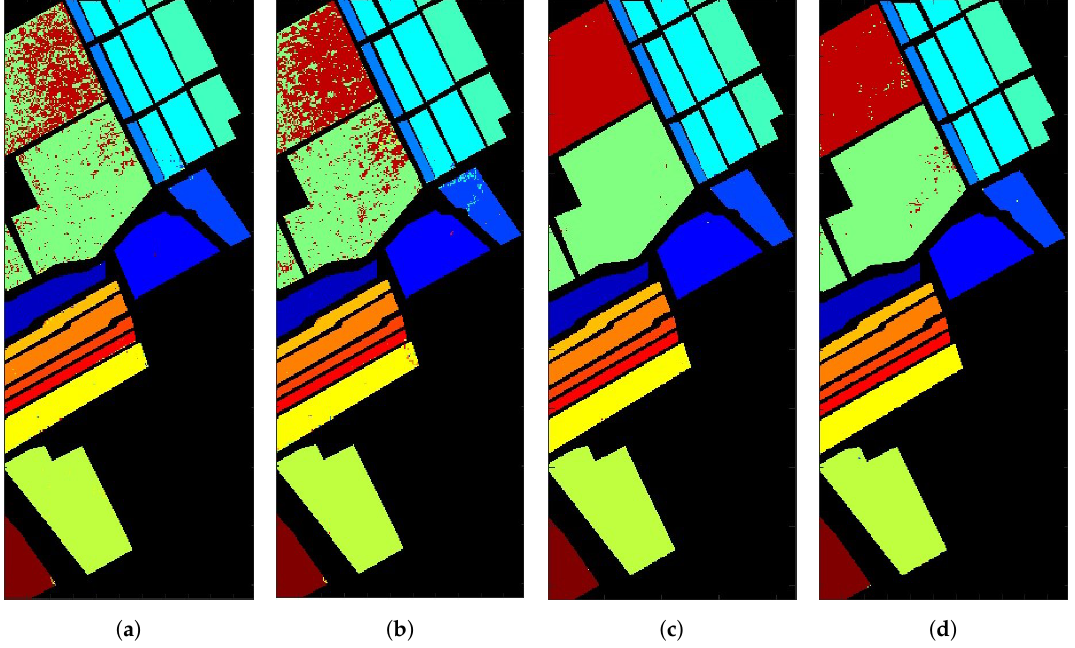
Figure 16. Classification images on Salinas Valley HSI, ( a ) 1D-CNN with 204 bands, overall accuracy (OA) is 91.8%, ( b ) BSCNN with 70 selected bands, OA is 93.2%, ( c ) 1D-CNN with augmented input vectors of 645 (21 × 21 + 204) bands, OA is 99.8%, ( d ) 2D-CNN with input layer composed of one principal component from each pixel, OA is 99%, color code the same as in Figure